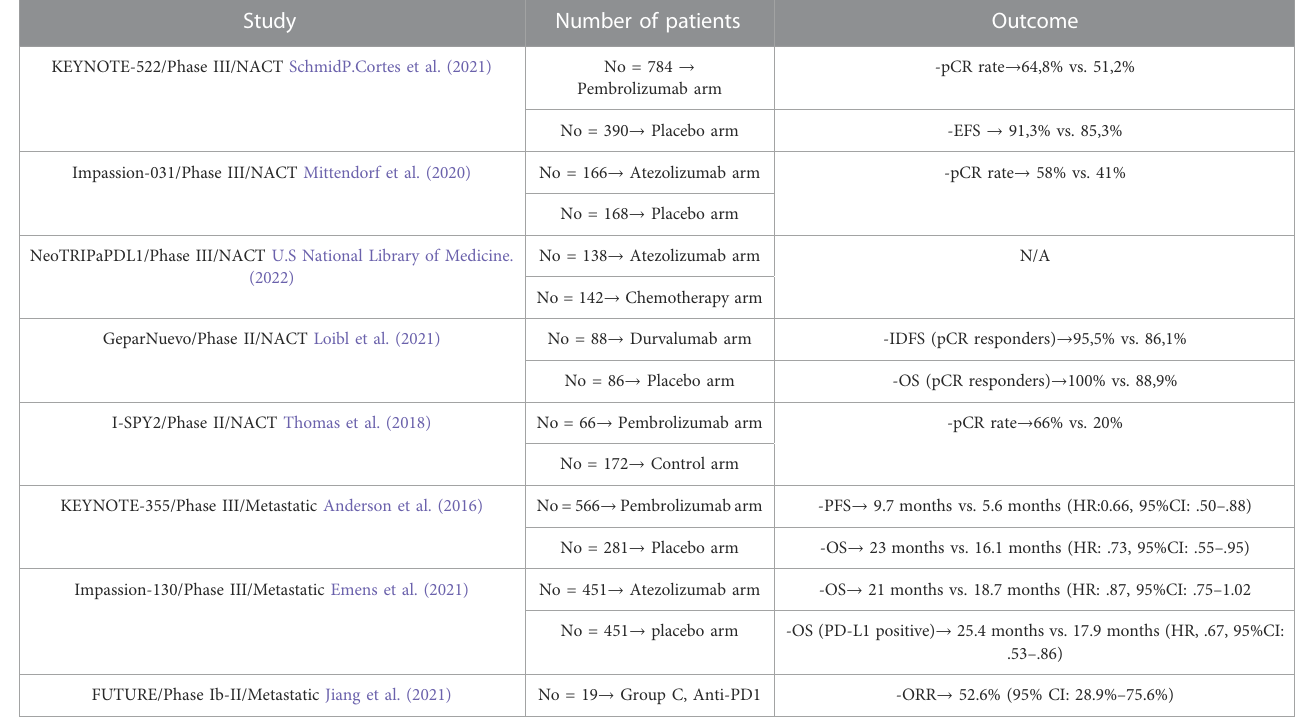
TABLE 2 Clinical trials with the incorporation of ICIs in TNBC. Study Number of patients